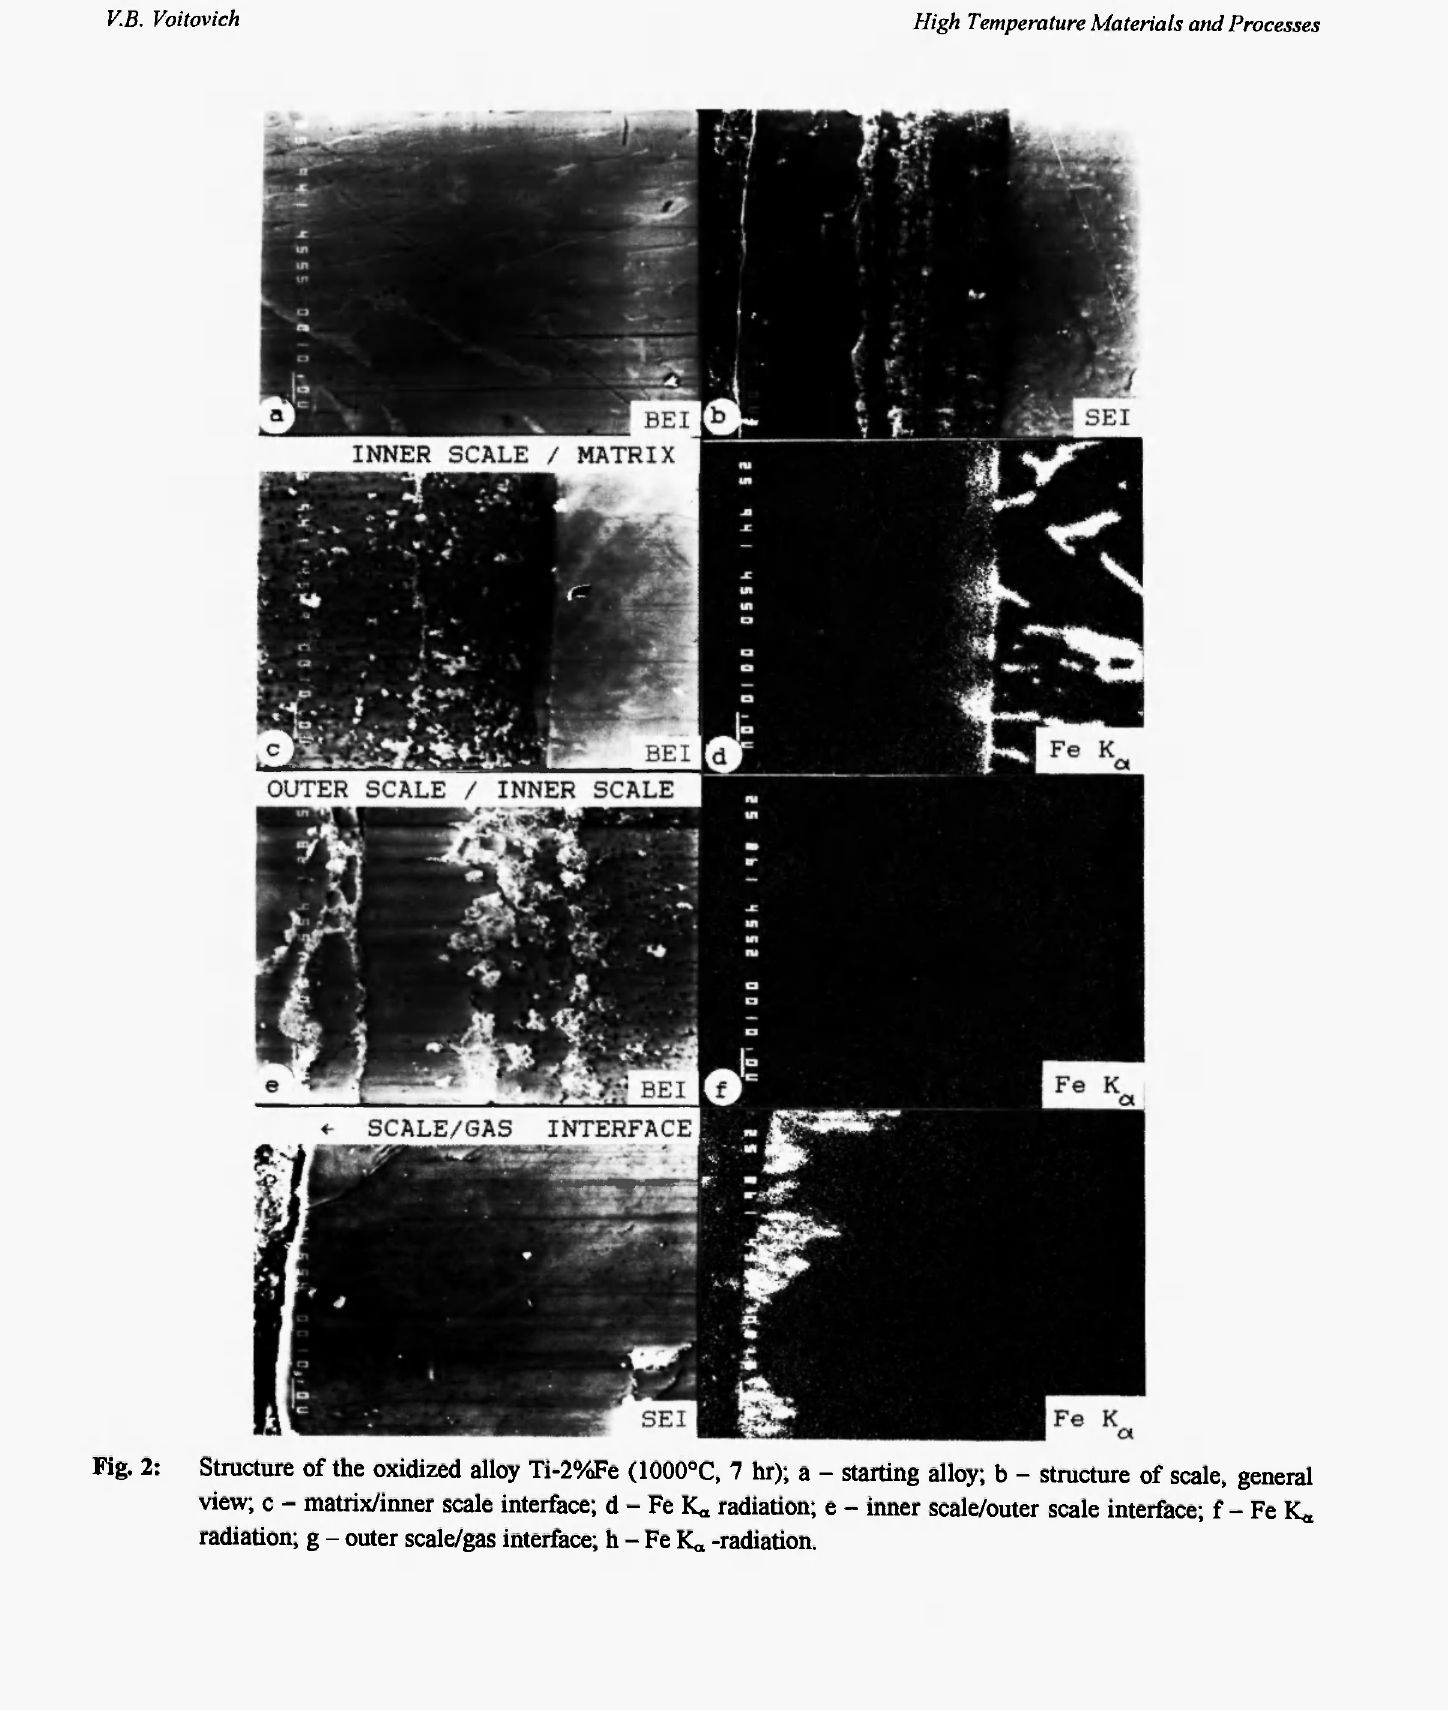
Fig. 2: Structure of the oxidized alloy Ti-2%Fe (1000°C, 7 hr); a - starting alloy; b - structure of scale, general view; c - matrix/inner scale interface; d - Fe K« radiation; e - inner scale/outer scale interface; f - Fe K« radiation; g - outer scale/gas interface; h-FeK^